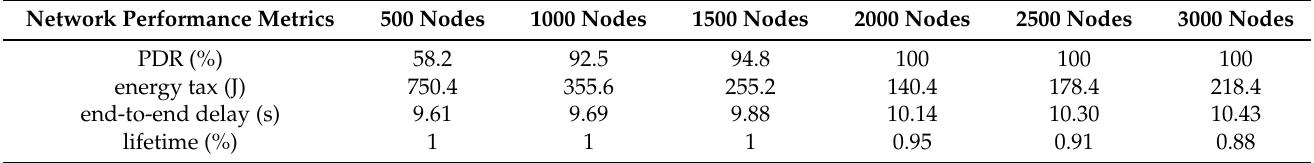
Table 3. Experimental results of different number of node with 1